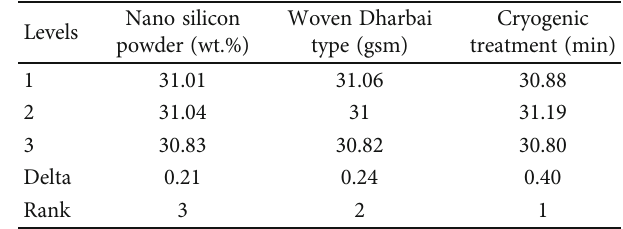
Table 4: Mean value of ILSS outcome. Table 5: S/N values of ILSS